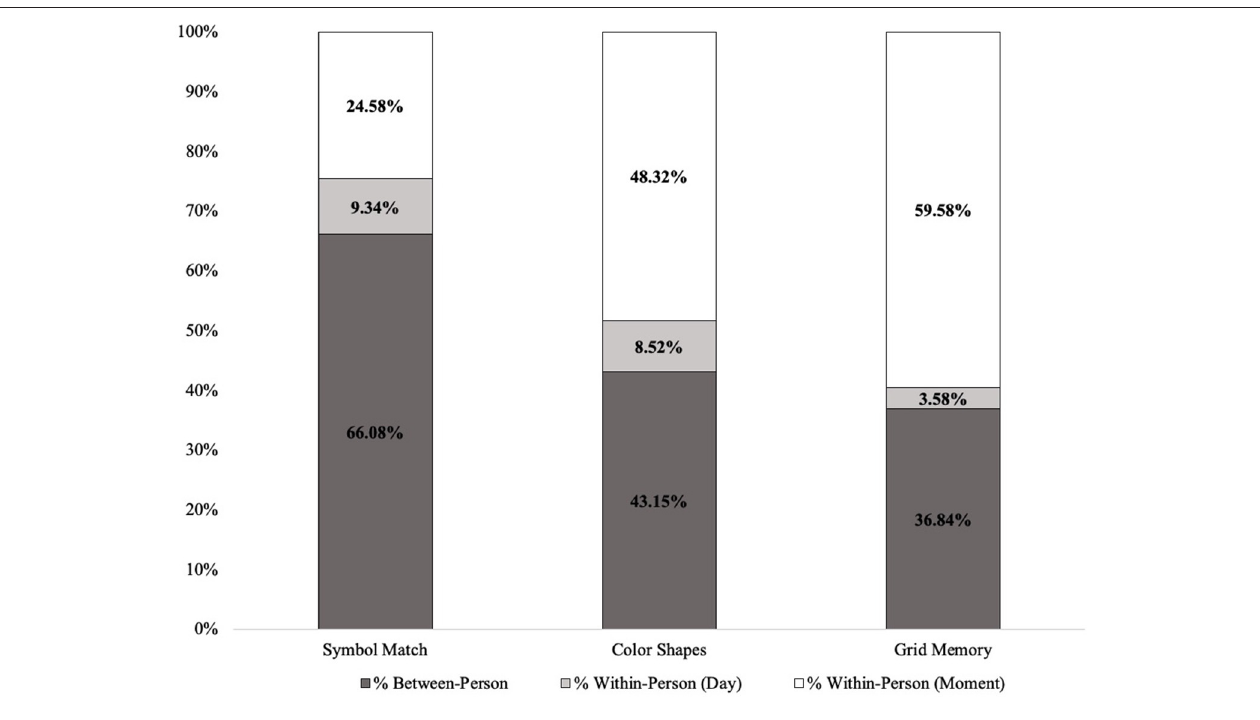
FIGURE 4 | Variance decompositions for mobile cognitive